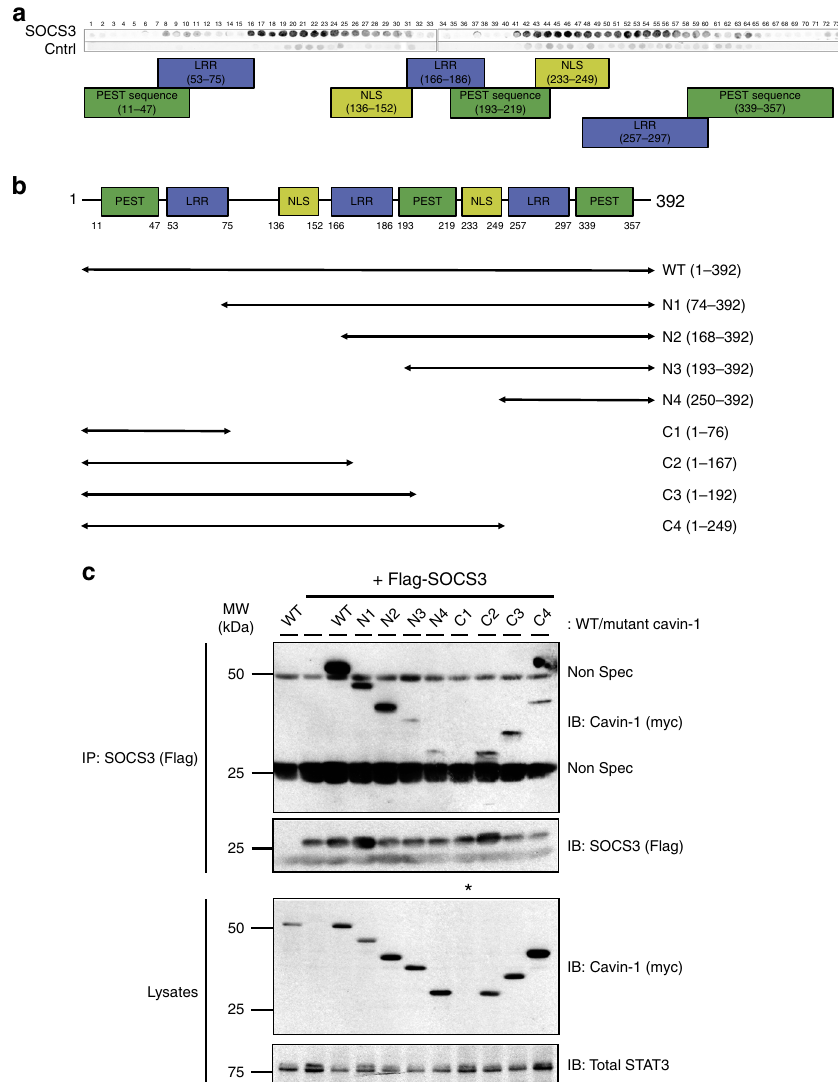
Fig. 6 SOCS3 interacts with multiple regions within cavin-1. a An immobilised library of 25-mer peptides sequentially shifted by 5 amino acids along the entire cavin-1 open reading frame was overlaid with either puri fi ed SOCS3 or a negative control (Cntrl). Dark spots represent areas of interaction between SOCS3 and peptides within the cavin-1 peptide array. The domain structure of murine cavin-1 is indicated below the overlay. b Schematic representation of the N- and C-terminally truncated myc-tagged cavin-1 mutants used for co-IP experiments. c Protein-equalised soluble cell extracts from HEK293 cells transfected with expression constructs encoding either myc-tagged WT cavin-1 or the indicated truncation mutants and Flag-tagged SOCS3 as indicated were processed by IP with anti-Flag M2-agarose beads prior to SDS-PAGE and immunoblotting with the indicated antibodies. Whole-cell lysates from the same samples used in the IP were also fractionated by SDS-PAGE for immunoblotting in parallel. *Indicates that expression of the C1 cavin-1 mutant was not detectable; Non Spec refers to immunoglobulin-derived non-speci fi c